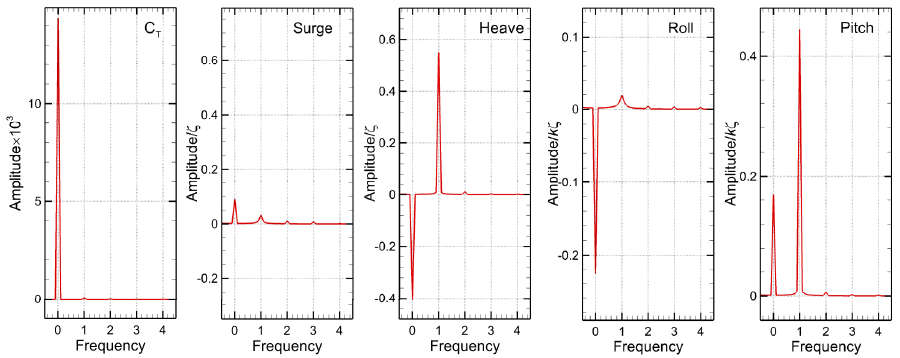
Figure 9. Harmonic amplitudes of the total resistance coefficient ( C T ) , surge ( x ) , heave ( z ) , roll ( ϕ ) and pitch ( θ ) for the head waves FRxz ϕθ scenario.